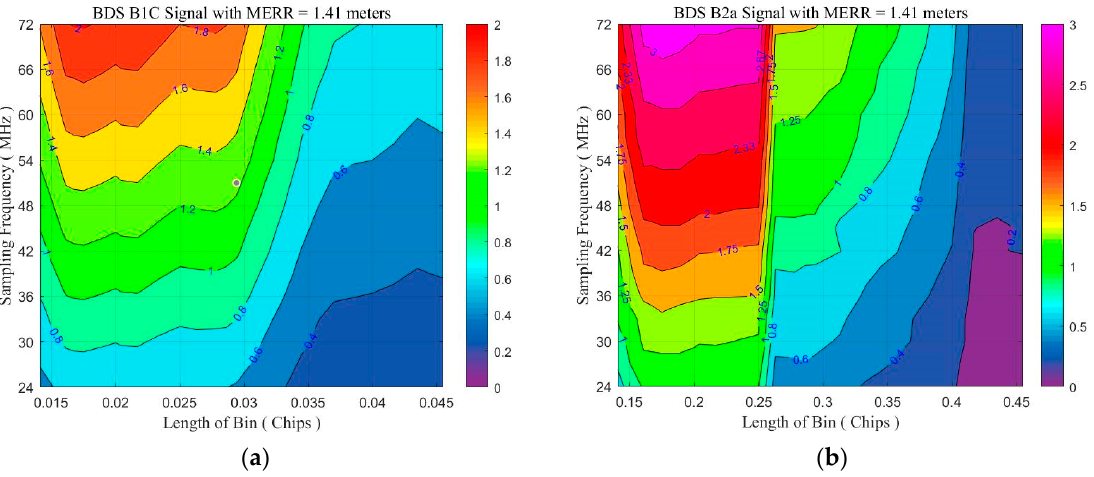
Figure 4. Contours of FoM values across the considered ranges of code-phase bin lengths and sampling frequency, with MERR = 1.41 m. ( a ) B1C signal; ( b ) B2a signal.